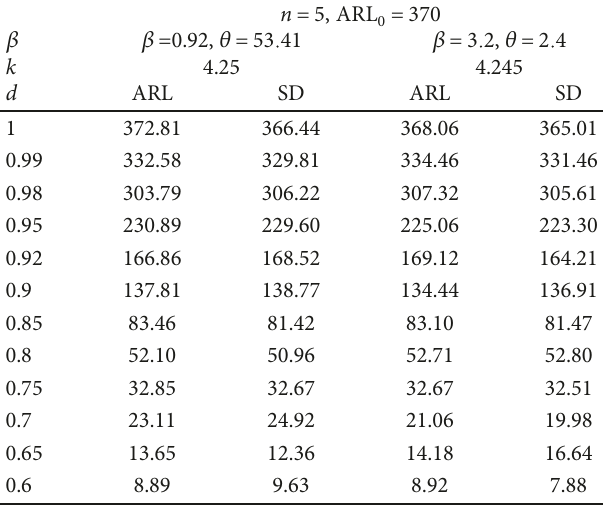
Table 5: The values of ARLs when q = 0 95 and α = 0 80